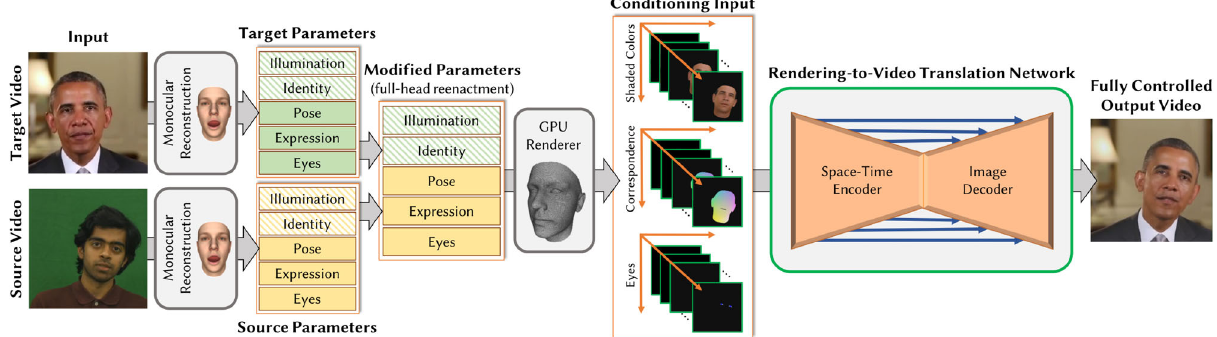
Fig. 15 Deep video portrait architecture for face reenactment. The method enables a source actor to control a target video portrait in terms of head pose, expression, etc. Left: a low-dimensional parametric representation of both videos is obtained using monocular face reconstruction. Center: head pose, expression, and eye gaze are transferred in parameter space. Right: rendering the photo-realistic video portrait of the target actor from input images. Obama video courtesy of the White House (public domain). Reproduced with permission from Ref. [163], c (cid:2) Association for Computing Machinery